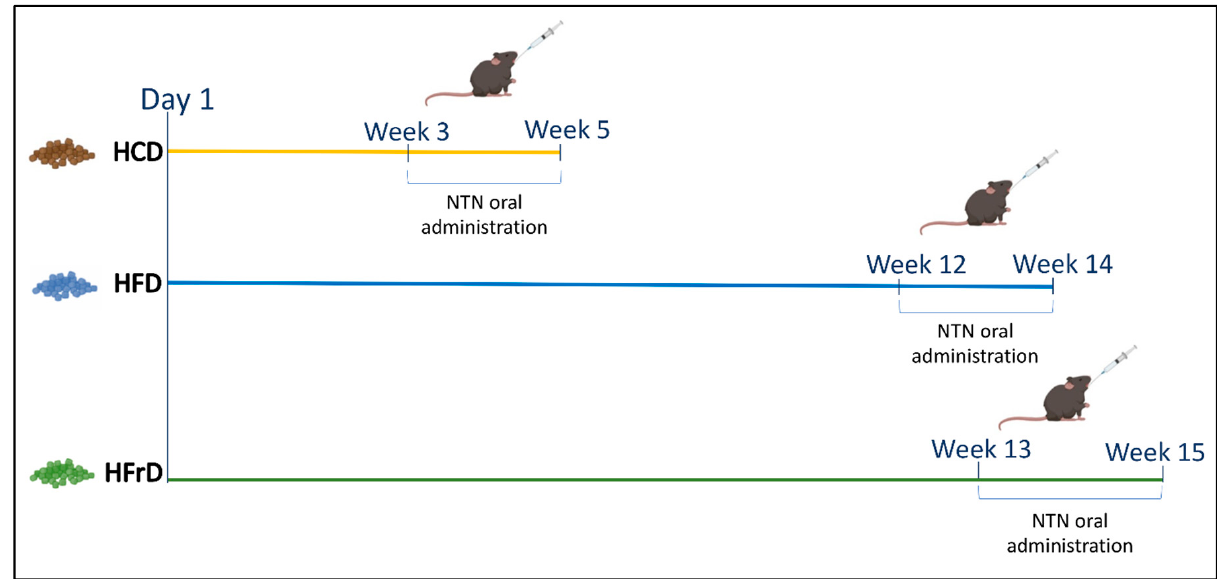
Figure 1. Timeline of FIs. The figure summarizes the timing of each experimental model. Five weeks for carbohydrate intolerance (the administration of NTN was conducted in the last two weeks); 14 weeks for lipid intolerance (the administration of NTN was carried out in the last two weeks); 15 weeks for fructose intolerance (the administration of NTN was carried out in the last two